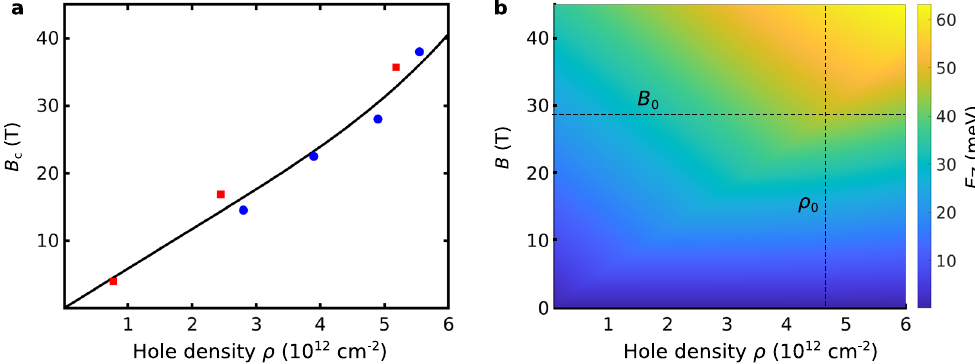
Fig. 3 Critical magnetic fi eld and Zeeman split. a Critical magnetic fi eld as a function of hole density. Blue circles: experiment 16 ; Red squares: our predictions ( b ) 2D plot for E Z as a function of hole density and external magnetic fi eld. This plot ignores valley- fi lling instability effects discussed in Fig.